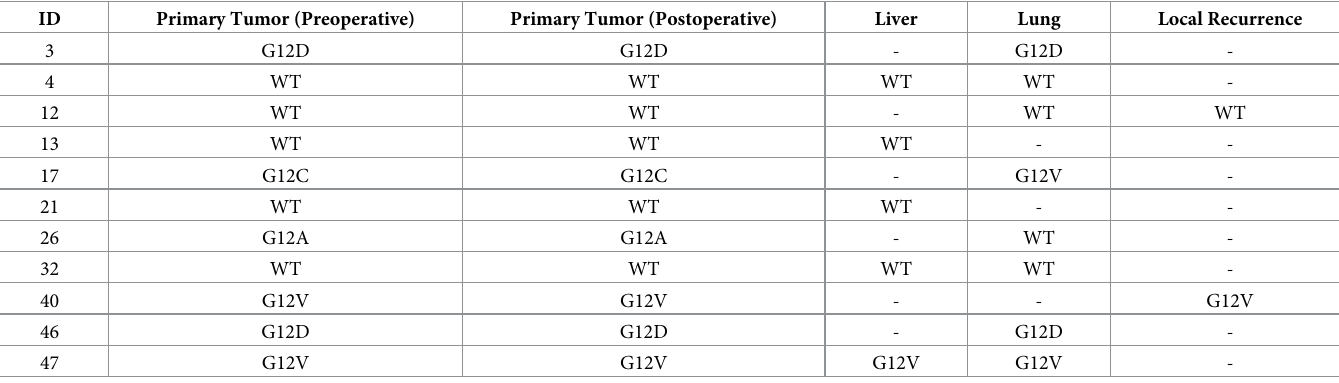
Table 2. KRAS mutation status in patients with metastasized rectal cancer.